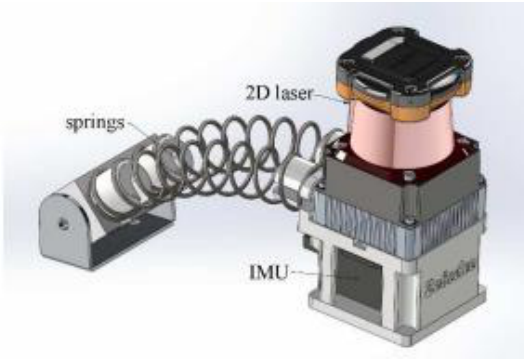
Figure 2. Handheld laser scanner